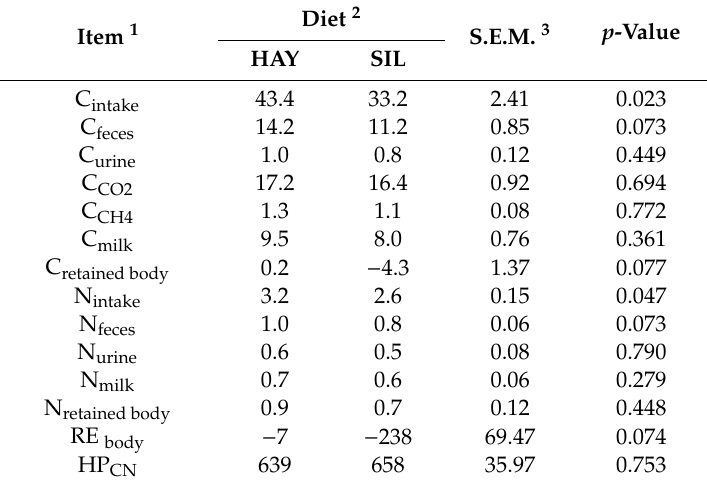
Table 7. CN method; carbon and nitrogen balance (g / kg BW 0.75 day) of 8 lactating